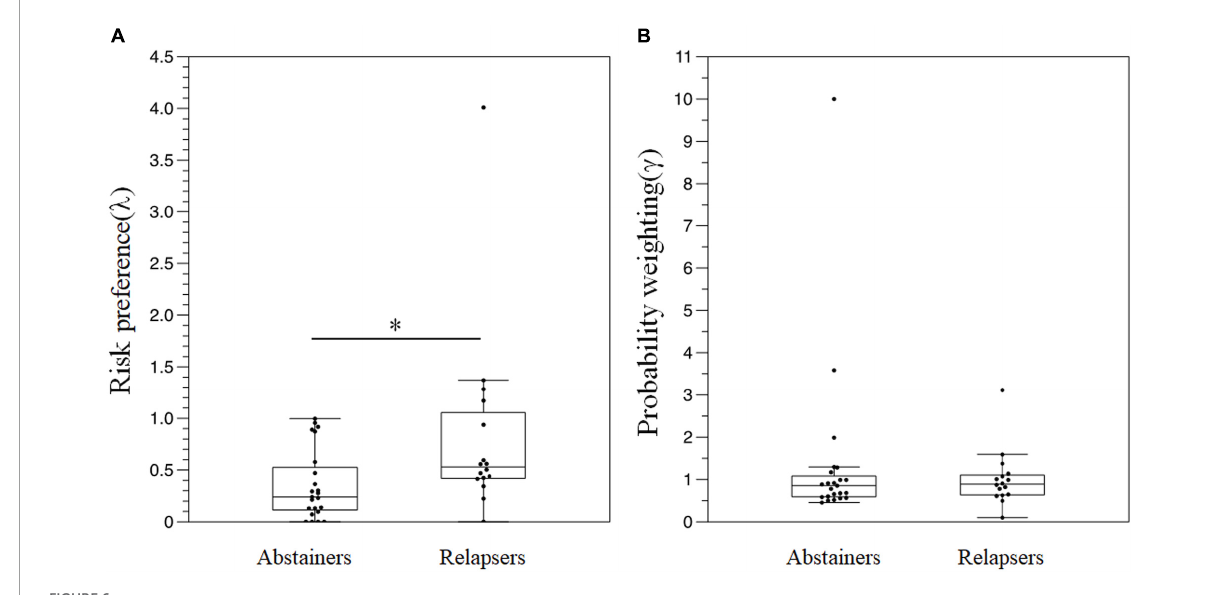
FIGURE6 A comparison of the results in the risk-based decision-making task between the groups. (A) λ (B) γ . ∗ P < 0.05.